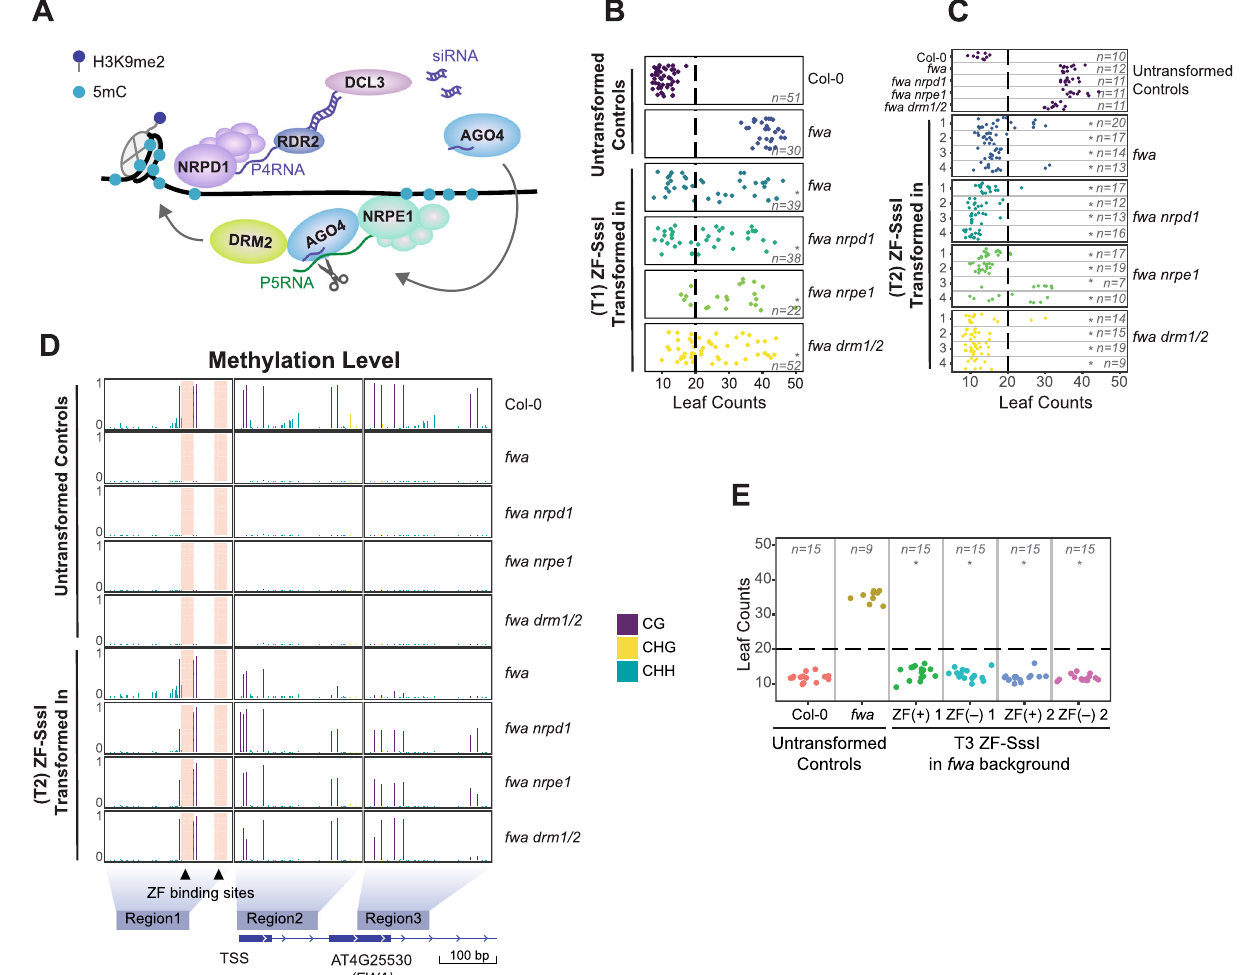
Fig. 1 SssI-targeted methylation at the FWA promoter cause silencing. A Cartoon depicting the RNA-directed DNA methylation pathway. B Flowering time of untransformed controls, and T1 ZF-SssI lines in the fwa background or mutants that have been introgressed into the fwa background. The X -axis represents the number of leaves. Each dot represents one individual plant. Dashed lines indicate the cutoff we chose to de fi ne ‘ early fl owering ’ versus ‘ late fl owering ’ ( *p- value < 0.01 compared to fwa , Welch two-sample t- test). C Flowering time of untransformed control lines and four representative ZF-SssI T2 lines in the fwa background or mutants that have been introgressed into the fwa background (* p- value < 0.01 compared to relative controls, Welch two- sample t -test). D CG, CHG, and CHH methylation levels over the FWA promoter measured by bisul fi te (BS)-PCR-seq in untransformed controls and ZF- SssI in the fwa background or mutants that have been introgressed into the fwa background. The barplot represents data from one representative T2 plant for each genotype tested. Every single bar represents one cytosine. Black triangles and orange shaded rectangle regions indicate the designed ZF binding sites. The relative position of the three regions analyzed in the FWA gene are indicated as blue squares. E Flowering time of untransformed Col-0, fwa , and two representative T3 ZF-SssI lines with ( + ) or without ( ‒ ) the transgene. (* p- value < 0.01 compared to fwa , Welch two-sample t -test). Source data underlying Figs. 1B, 1C, and 1E are provided as a Source Data fi